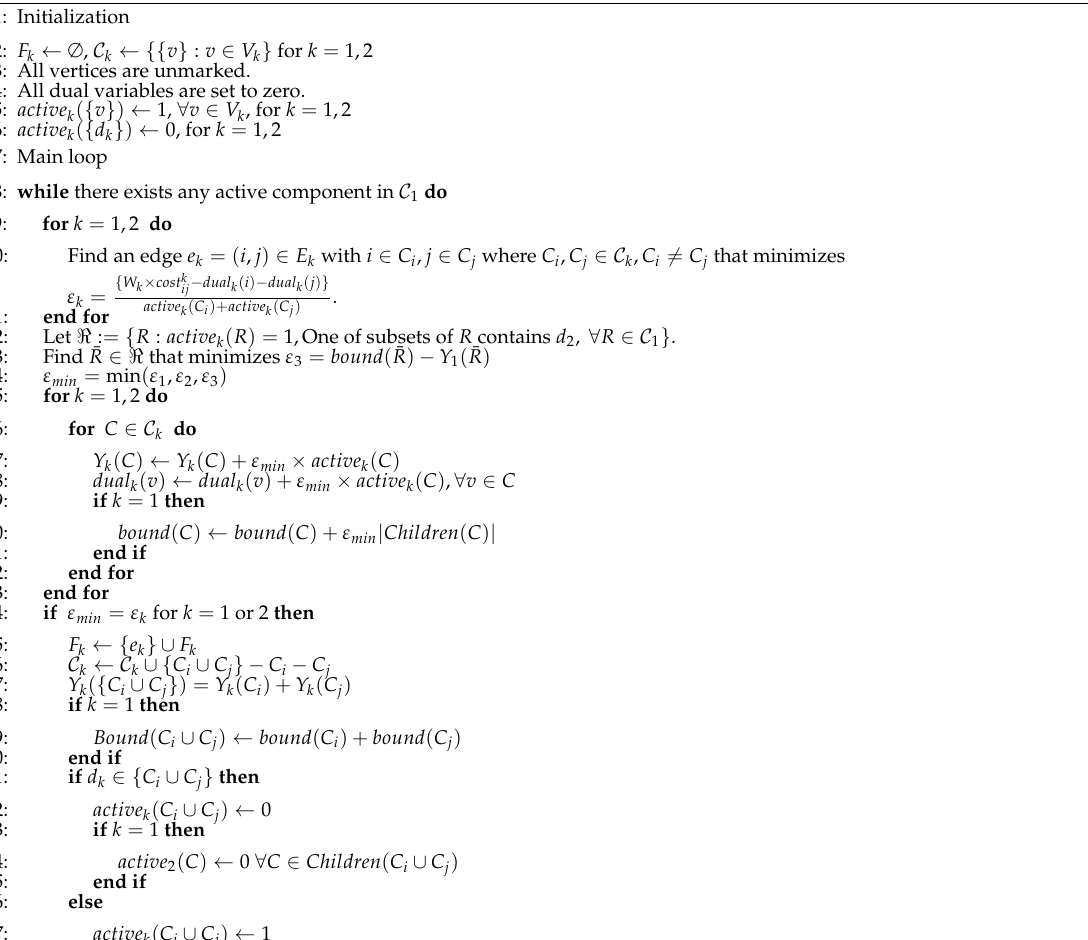
Algorithm 2 Primal-dual heuristic for finding an